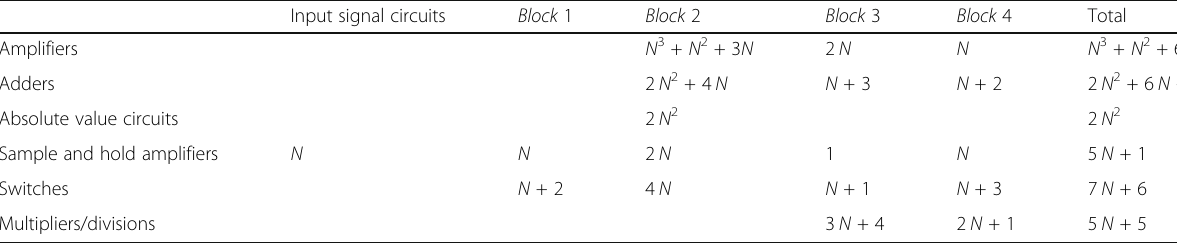
Table 1 The number of the most represented circuits required